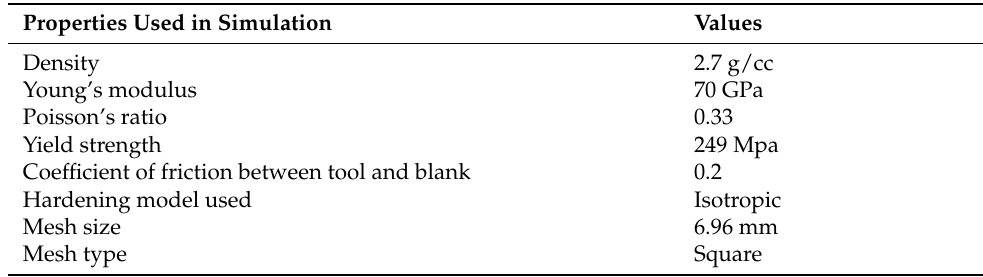
Table 1. Details of parameters used in